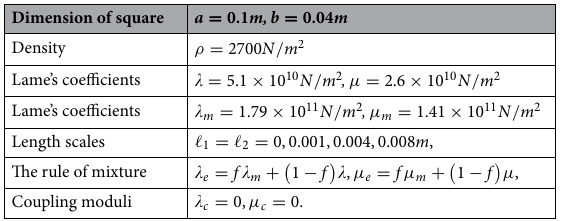
Table 1. The material